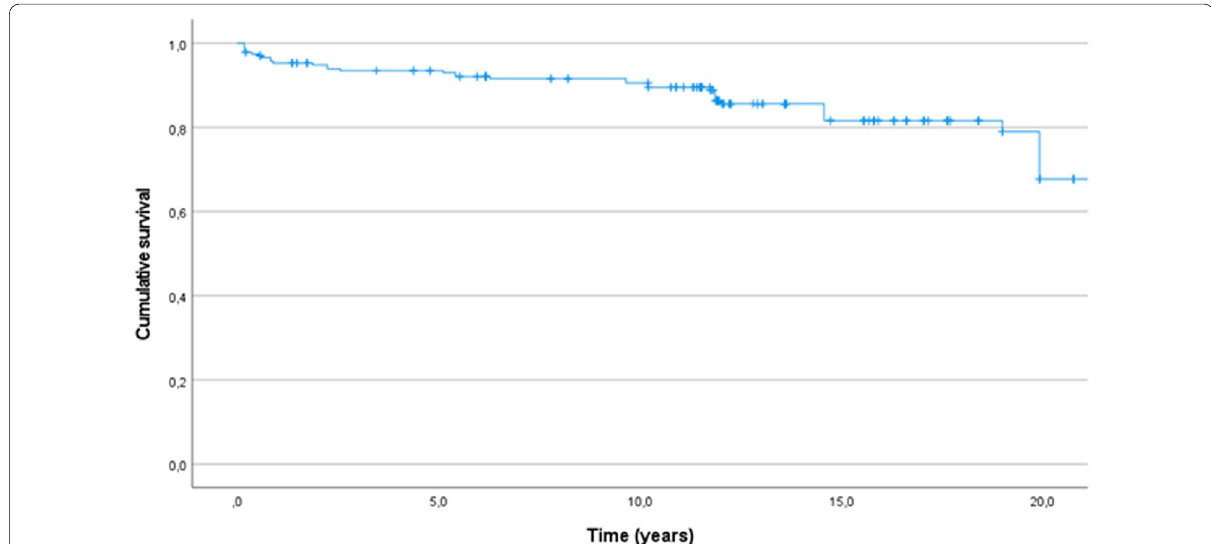
Fig. 2 Kaplan–Meier curve for overall anterior implant survival over the course of 20